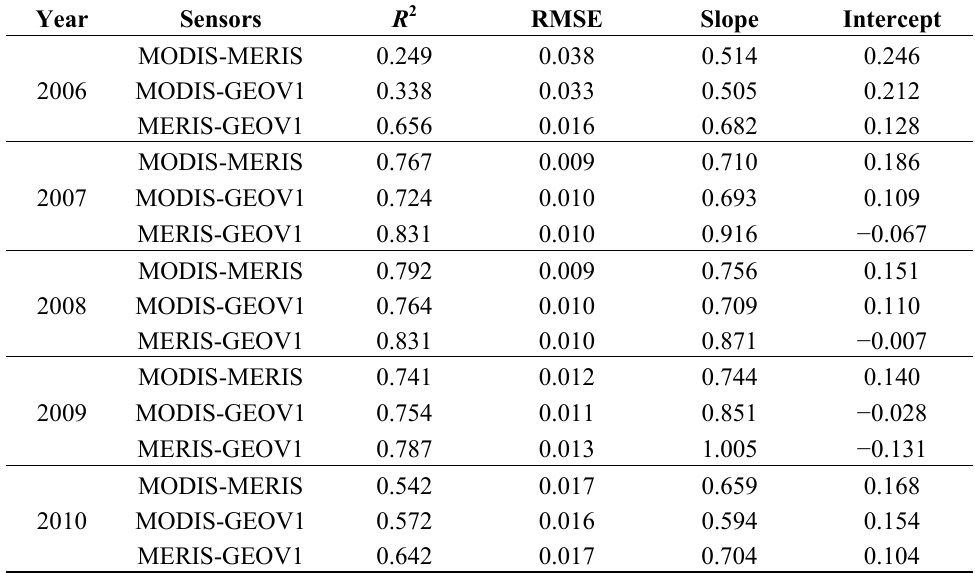
Table A1. Maize FPAR relationships among MODIS, MERIS and GEOV1